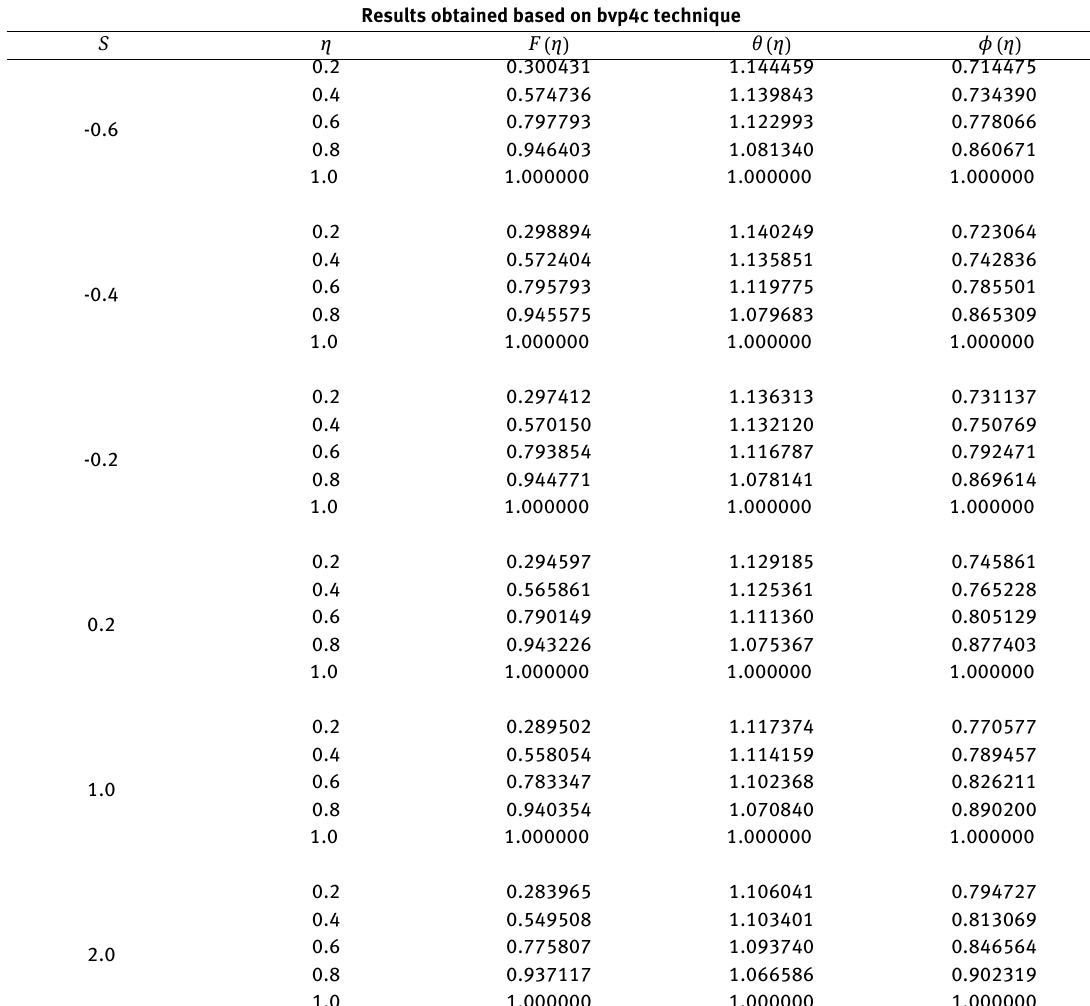
Table 3: Numerical values of F ( η ) , θ ( η ) and ϕ ( η ) for different set of S , obtained based on bvp4c scheme with fixed values of β = 0.7, Ha =